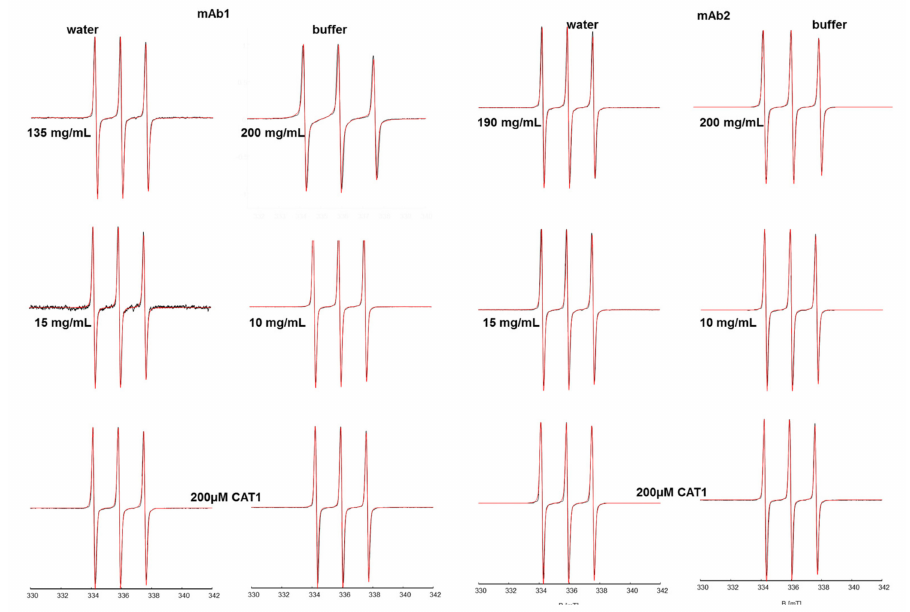
Figure 2. Experimental (black) and simulated (red) X-band CW EPR spectra of CAT1 in mAb1and mAb2 solutions of di ff erent concentrations in pure water and bu ff er are shown. Also, the spectra of 200 µ M spin probe solutions in water and bu ff er as reference are